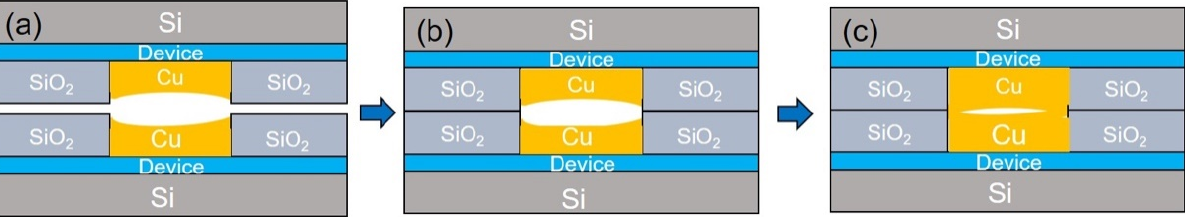
Figure 9. Schematic of the bonding mechanism with non-uniform bonding surfaces in a Cu/SiO 2 hybrid system. ( a ) Sides with Cu bumps in SiO 2 via. The non-uniformity (dish shape) on Cu surface is generated after the CMP process ( b ) Alignment and bonding of SiO 2 to SiO 2 at room temperature with dishing Cu. ( c ) The periphery of the Cu vias can be well-bonded after high temperature annealing. No external pressure is needed at the third stage.